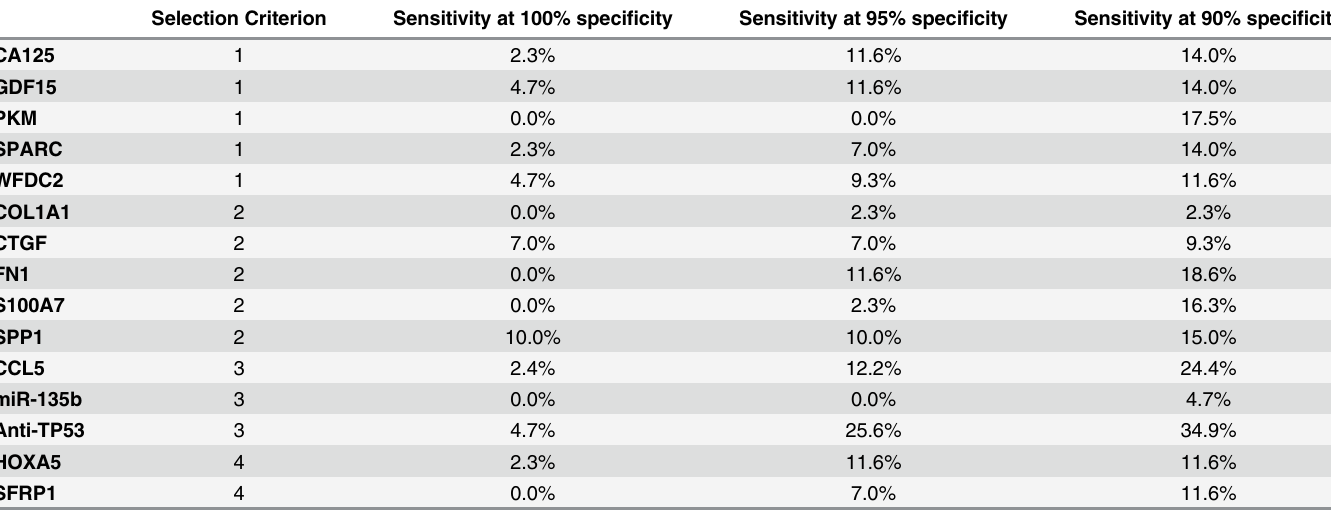
Table 2. Selection of 15 analytes and their sensitivity/specificity as serum markers.